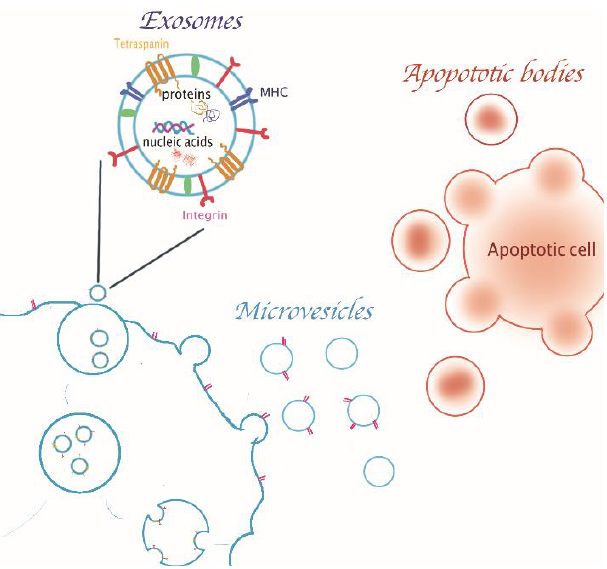
Figure 1. Extracellular vesicles biogenesis and a specific focus on exosome composition. Exosomes originate intracellularly as intraluminal vesicles of the multivesicular bodies; microvesicles originate from the outwards budding and fission of plasma membrane; apoptotic bodies are caused by the fragmentation of the apoptotic cells. The exosomes membrane is composed by different kinds of lipids and proteins and they can carry inside cytosol-derived molecules, such as proteins and nucleic acids.